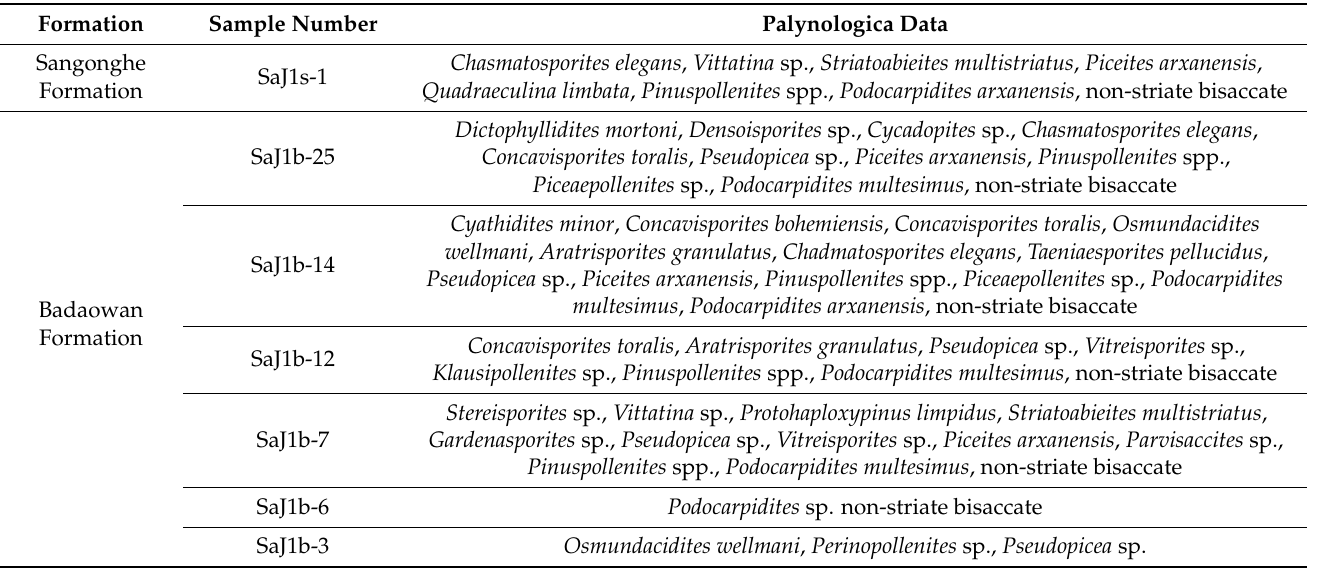
Table 3. List of the palynological data identified from the Su’asugou section in Yili Basin, NW China.